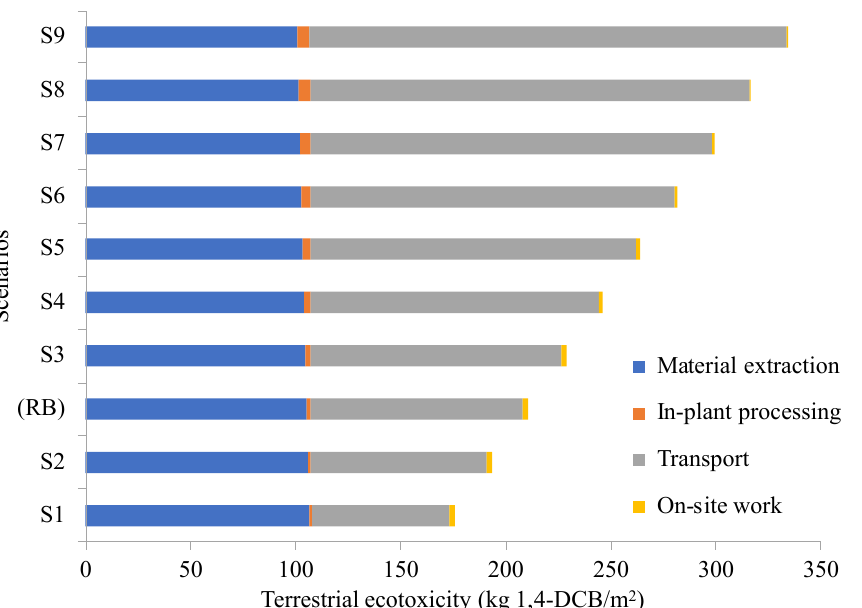
Figure 5. Changes in terrestrial ecotoxicity during each lifecycle stage in the scenarios.